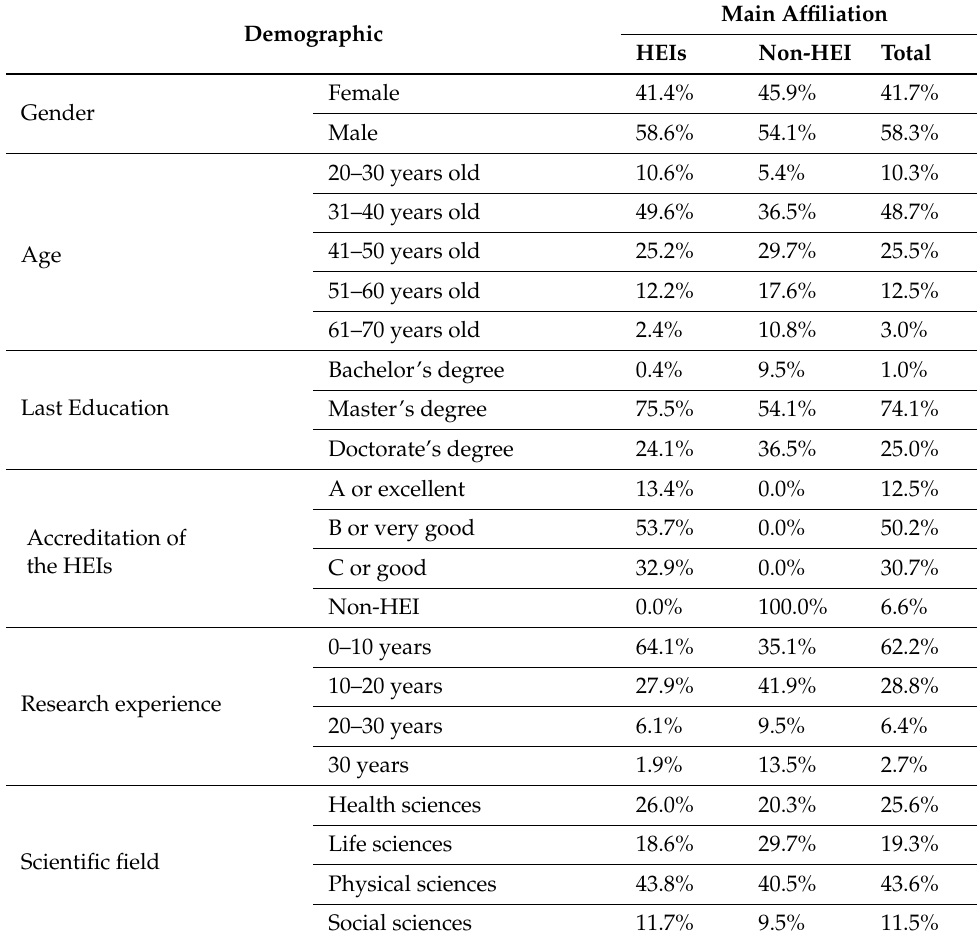
Table 2. The respondent’s demographic